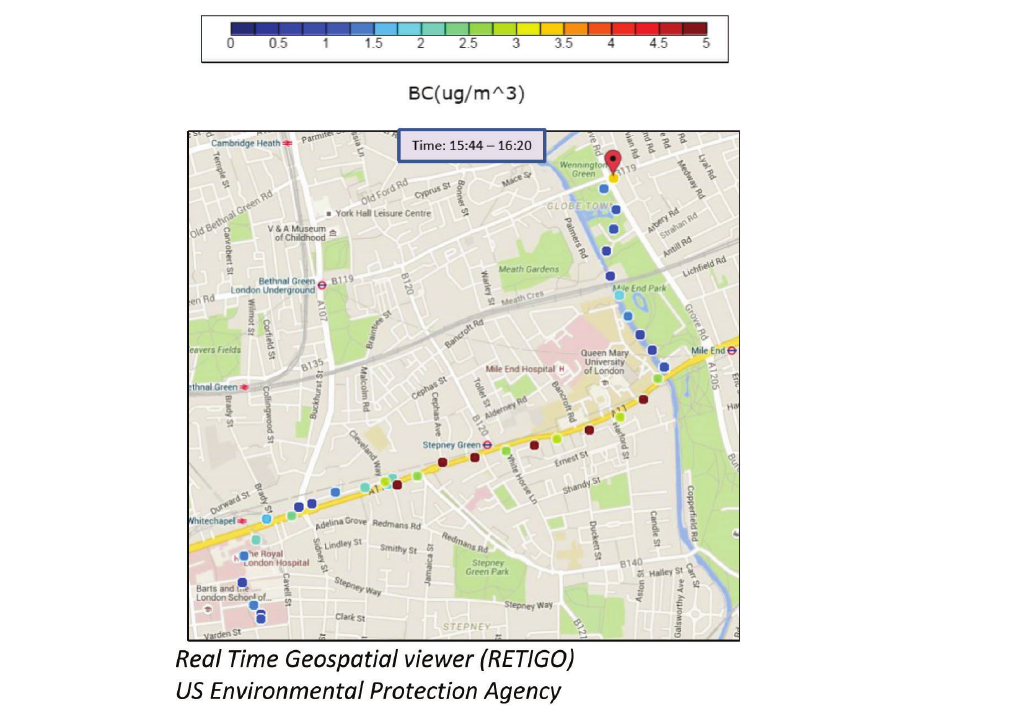
Figure 5: Example of the maps given to the